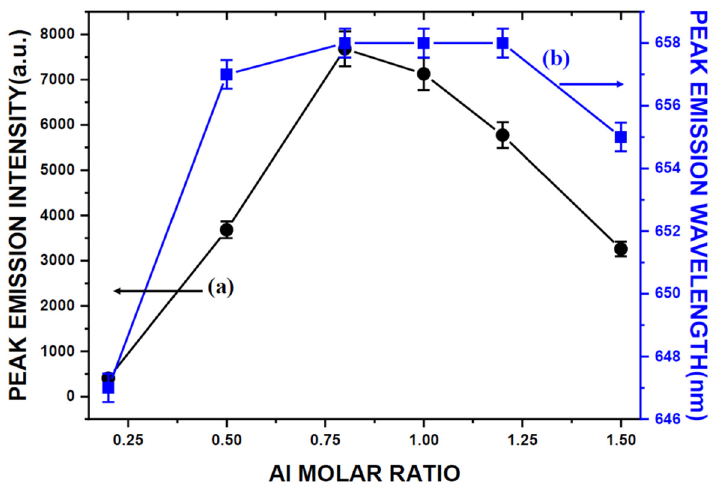
Figure 7. Dependence of ( a ) peak emission intensity and ( b ) peak emission wavelength on the Al molar ratio.